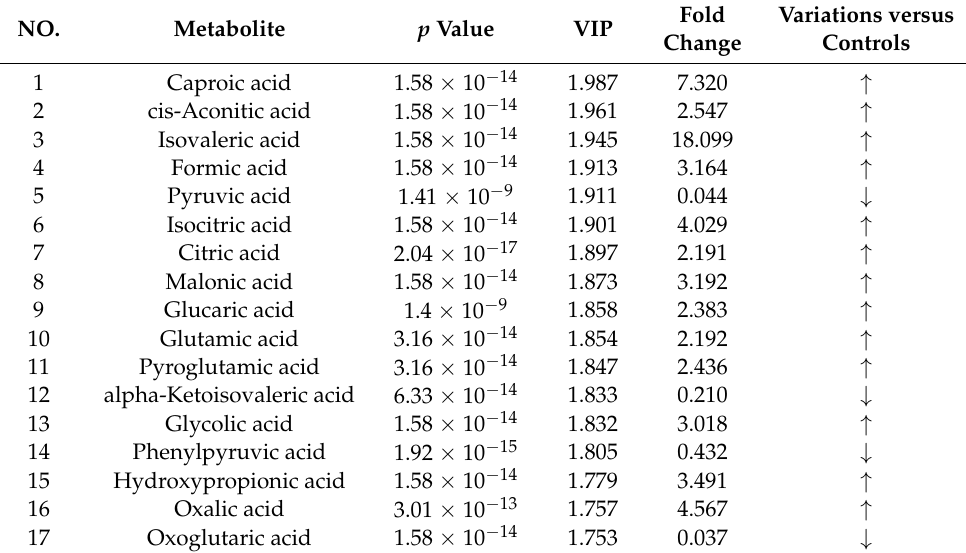
Table 1. Differential metabolites screened from the METH and control